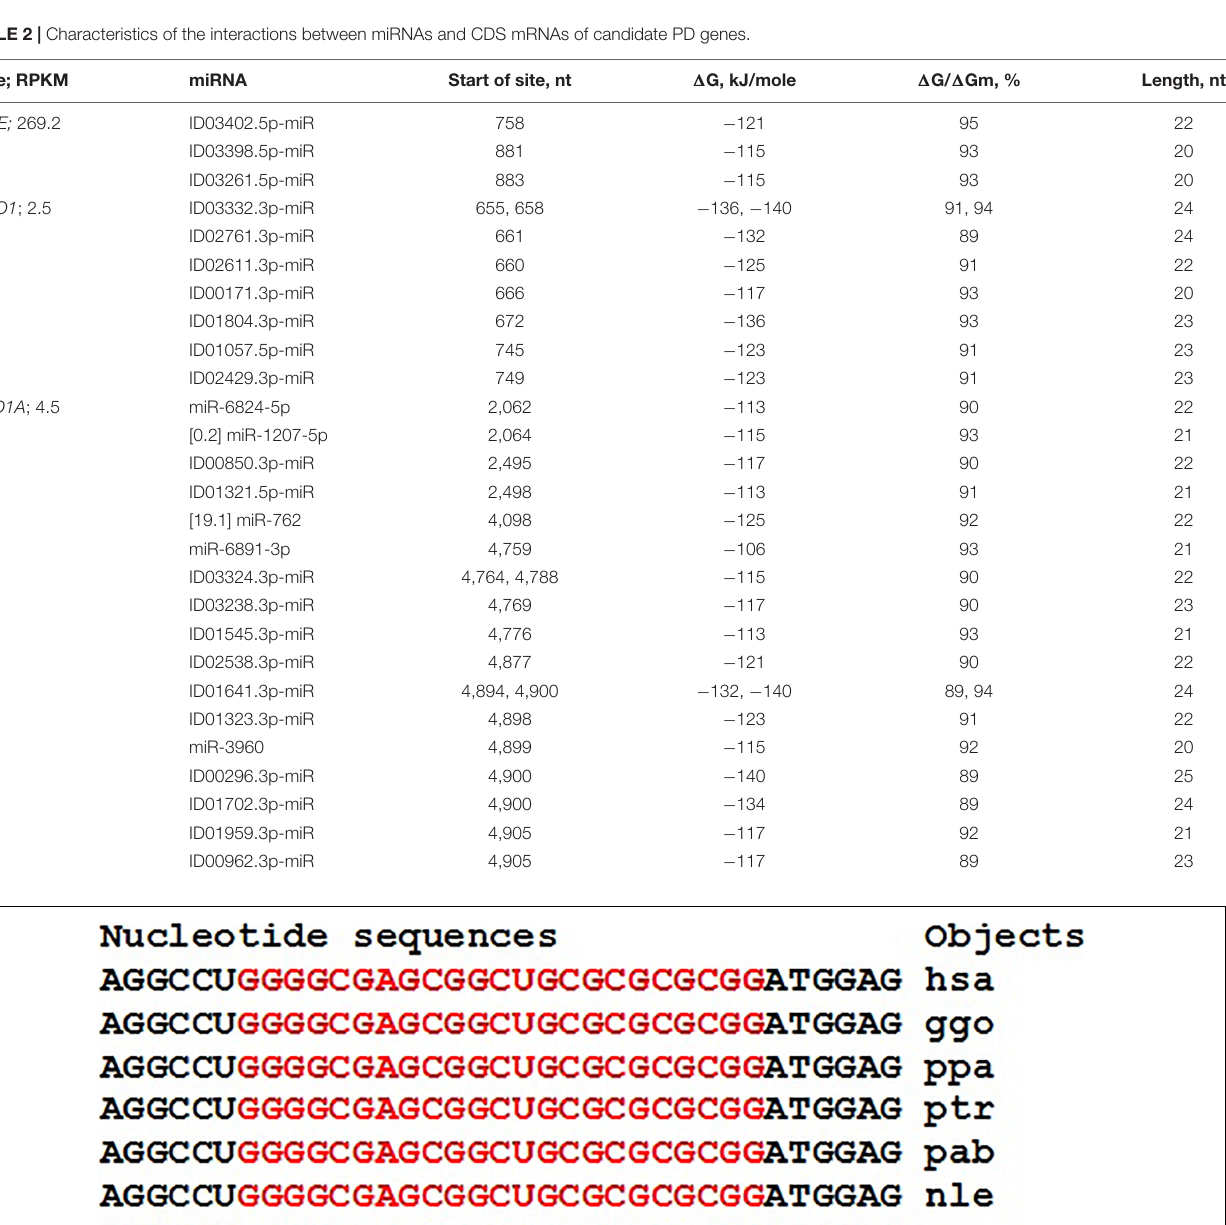
example, only ID02732.3p-miR was associated with the mRNA of the PRKN gene, exhibiting a (cid:49) G value of − 132 kJ/mole. The cluster of miR-5095 and miR-619-5p BS in the mRNA of the SLC14A1 gene is conserved in part of miR-619-5p binding (GGCUCACACCUGUAAUCCCAGC) and is variable in the six nucleotide segment that binds to miR-5095 ( Figure 13 ). Flanking nucleotides from the 3-end of the cluster are the same for all objects (ACUUUGGG) and coincide with the flanking nucleotides of the 3-end of the cluster in the mRNA of the PRKN gene of most objects ( Figure 14